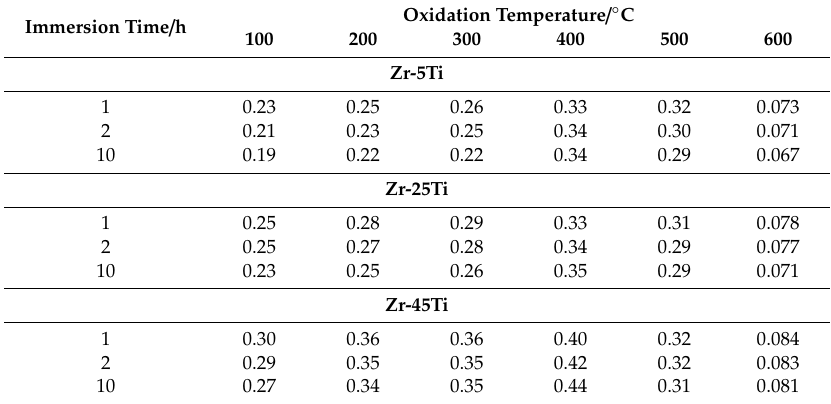
Table 4. Values of the polarization resistance (in M Ω · cm 2 ) as a function of immersion time of thermally oxidized Zr-Ti alloys in phosphate bu ff ered saline solution acidified at pH = 5.0 ± 0.1 Immersion Time / h